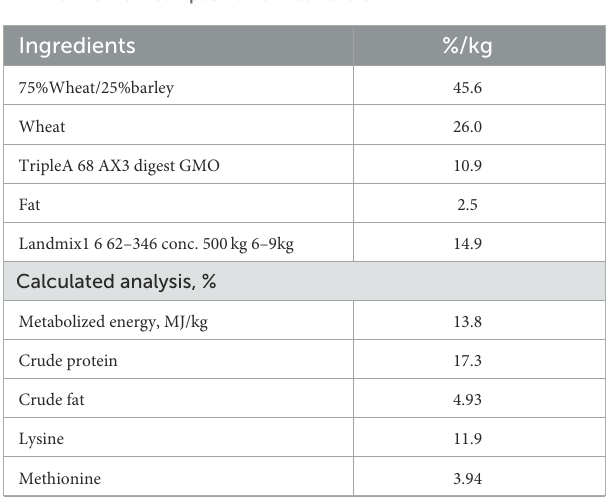
TABLE 3 Nutrient composition of weaner